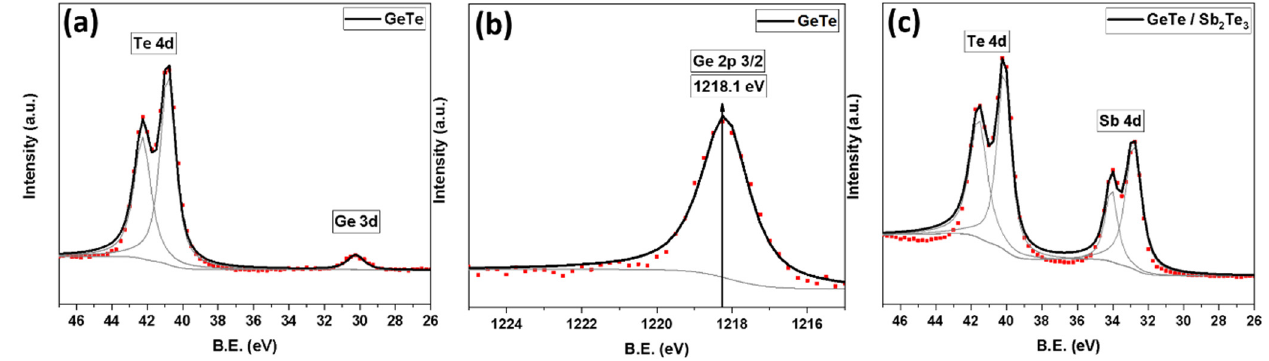
Figure 6. XPS spectra for ( a ) Ge_3d and Te_4d; ( b ) Ge_2p region for GT core NWs; ( c ) Sb_4d and Te_4d region for GT/ST core-shell with 10 nm shell thickness; (dots–experimental data; solid lines— fit).